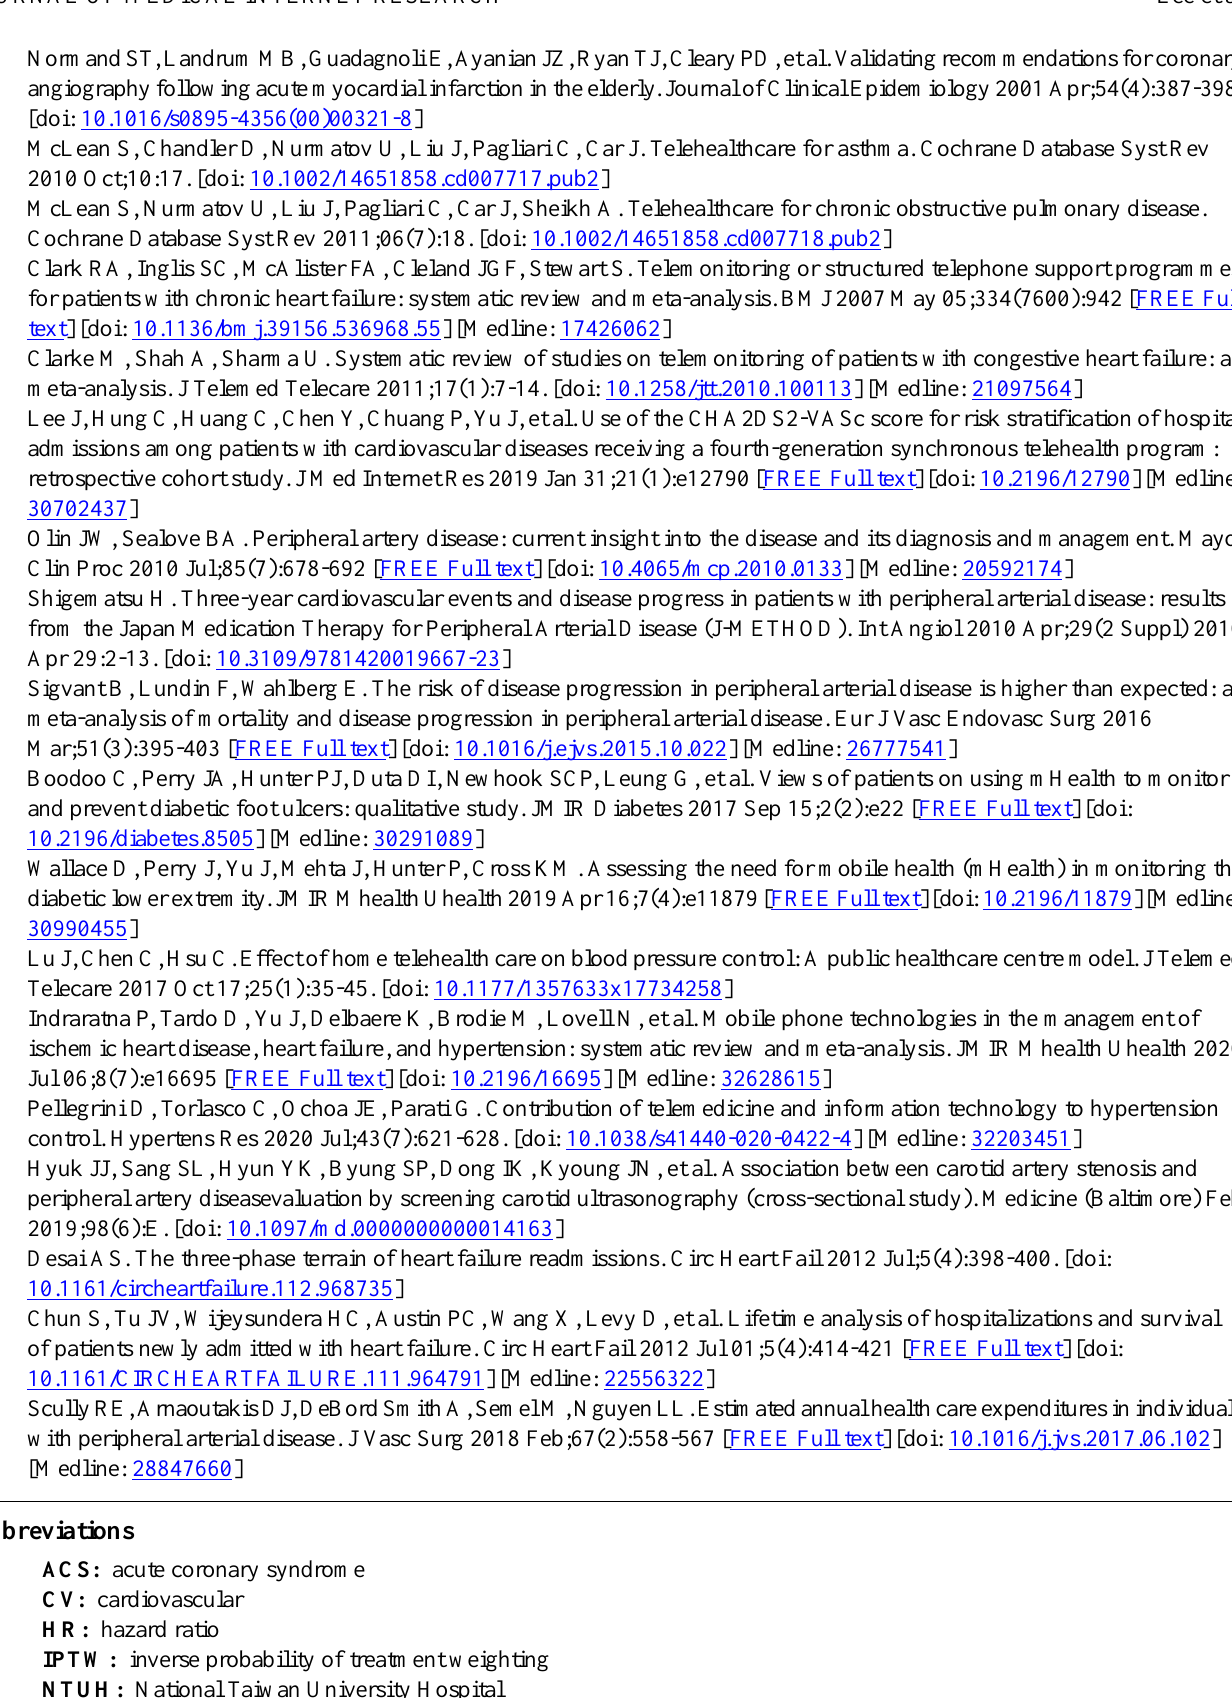
IPTW: inverse probability of treatment weighting NTUH: National Taiwan University Hospital PAD: peripheral artery